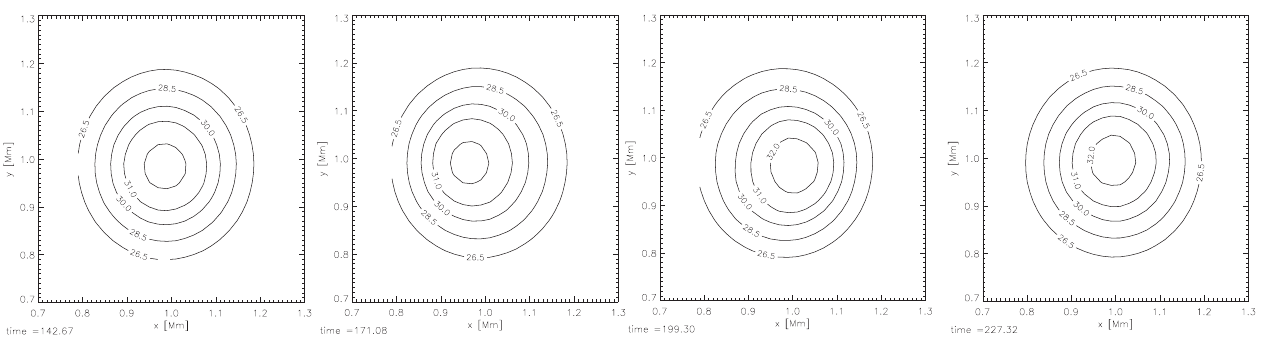
Fig. 5. A time series of horizontal cuts at height h = 0 . 75Mm of the total magnetic field. The strength of the magnetic field is shown as iso-contours. The difference in time between the snapshots is approximately equal to 30s, i.e., the period of footpoint driver. Note the clear evidence of the sausage and kink oscillations which propagate along the magnetic flux